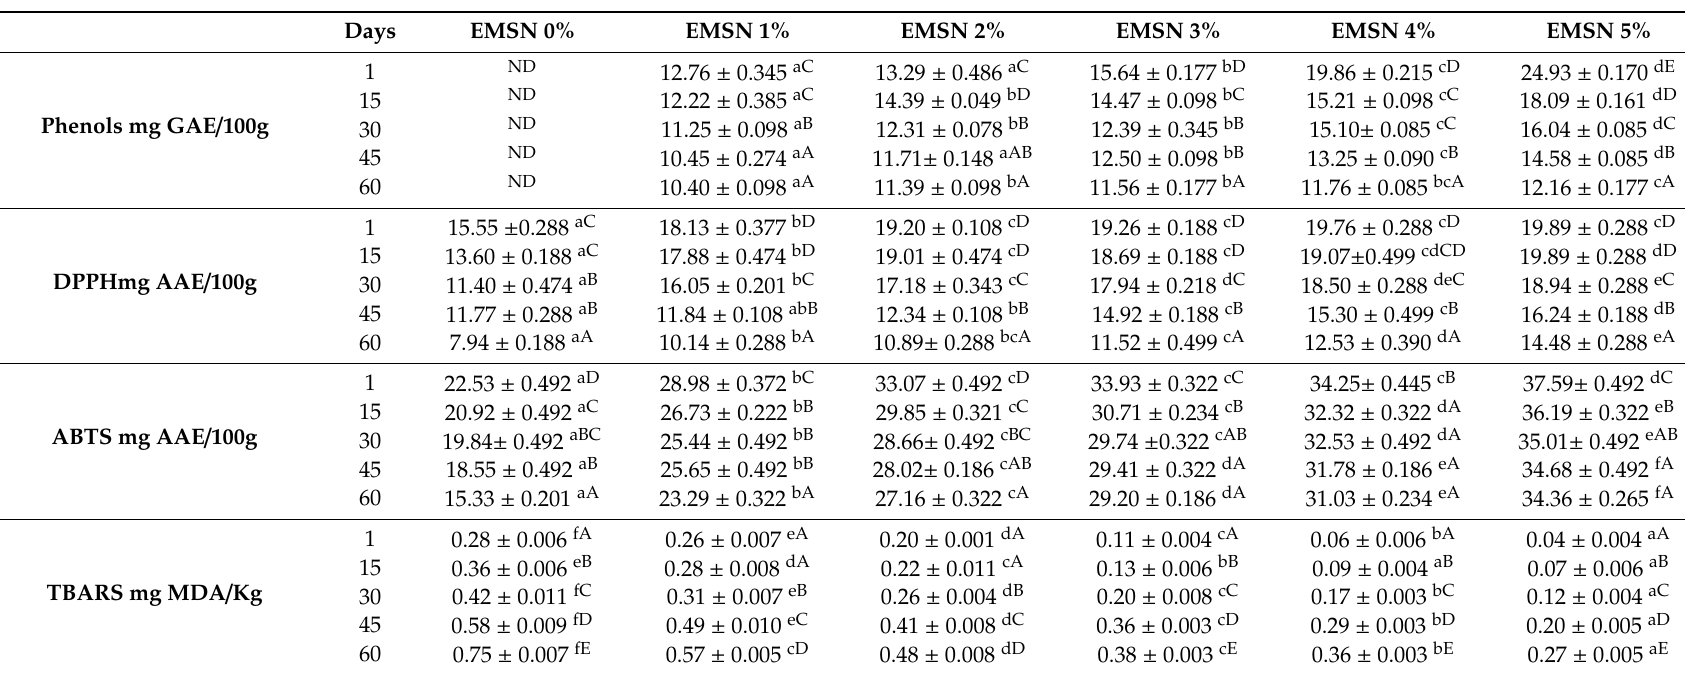
Table 4. Phenols, antioxidant activity via the DPPH and ABTS methods, and oxidative stability via the TBARS method in an emulsified meat system with